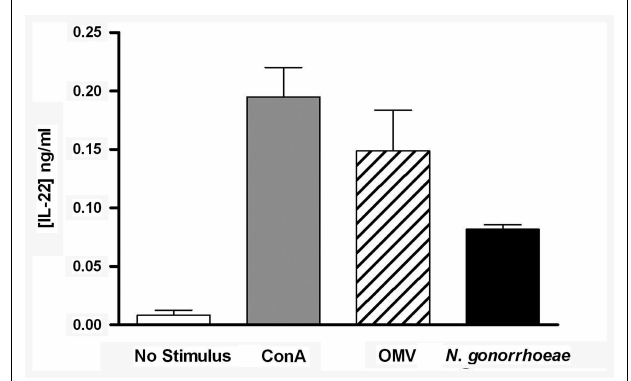
FIGURE 1 | Production of IL-22 from mouse splenic mononuclear cells, incubated in medium only (control), ConA (2 μ g/ml), N. gonorrhoeae (2 × 10 7 CFU/ml), or gonococcal OMV (5 μ g/ml) for 3days. Supernatants were assayed for IL-22 by ELISA. Data are shown as mean ± SD, N = 3, from one of three experiments yielding similar results.